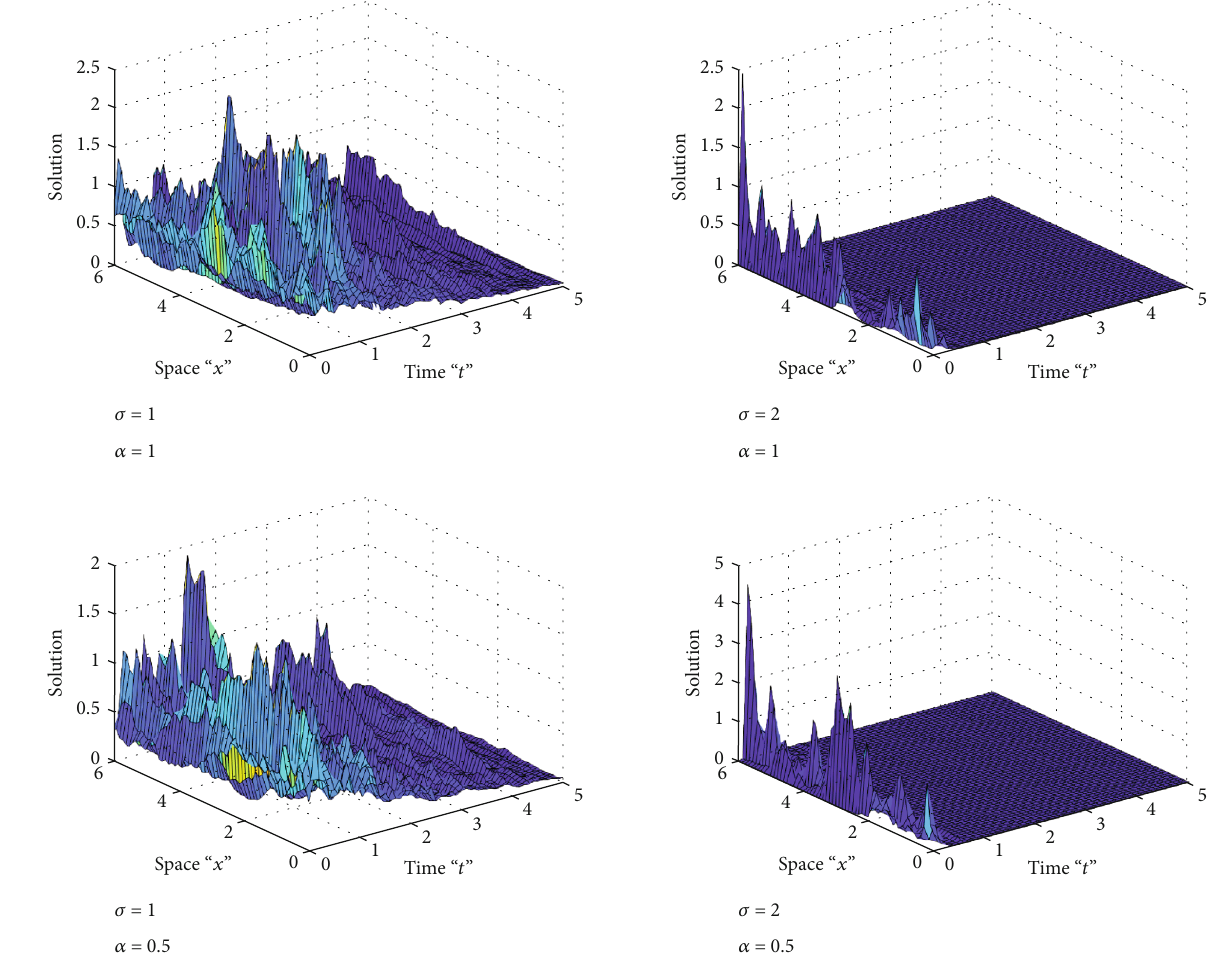
Figure 4: 3D-graph of Equation (34) with σ = 1, 2 and α = 1,0 : 5